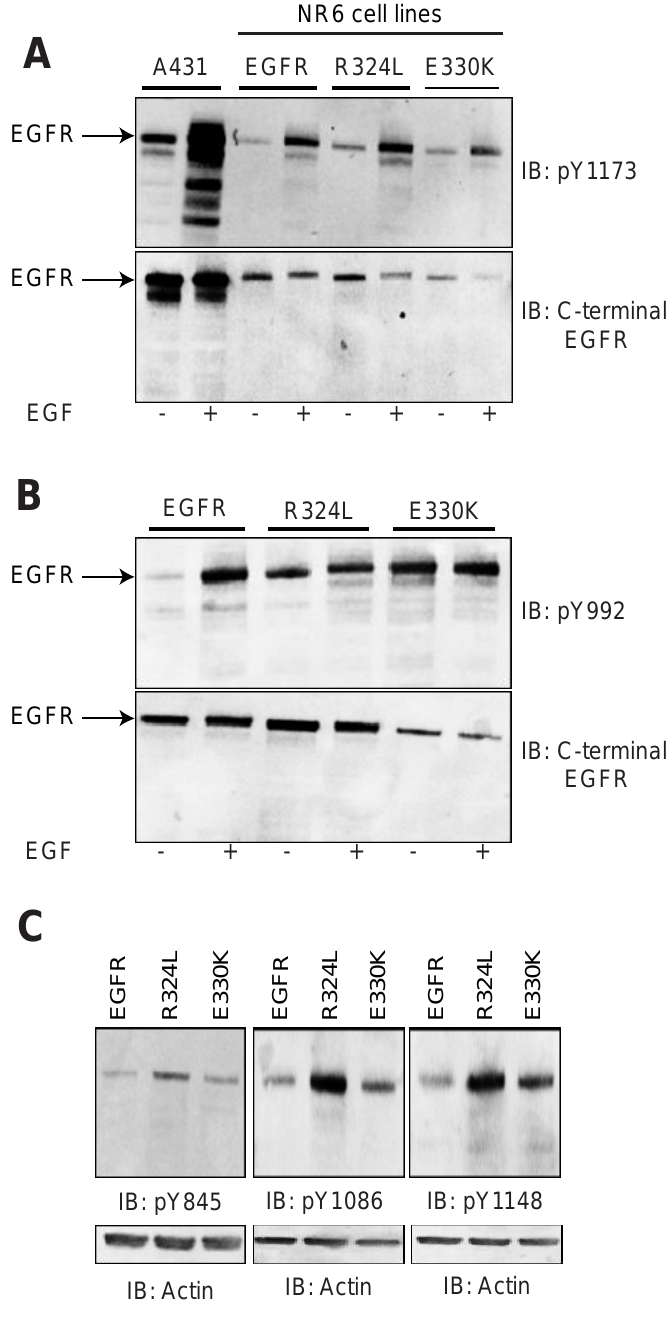
Figure 2. Activation of the EGFR mutants. Whole cell lysates (WCL) from NR6 cells expressing wtEGFR or the R324L and E330K mutants were analyzed by Western blot at multiple phosphorylation sites without or with EGF stimulation. ( A ). pY1173 analysis ( upper panel ) and C-terminal EGFR ( lower panel ). A431 cells that overexpress the EGFR were included as a positive control; ( B ). pY992 blot ( upper panel ) and C-terminal EGFR ( lower panel ); ( C ). Basal phosphorylation status of pY845 ( left ), pY1086 ( middle ) and pY1148 ( right ) blots and their corresponding actin loading controls. In all cases representative results from multiple repeats are shown. NR6 cell